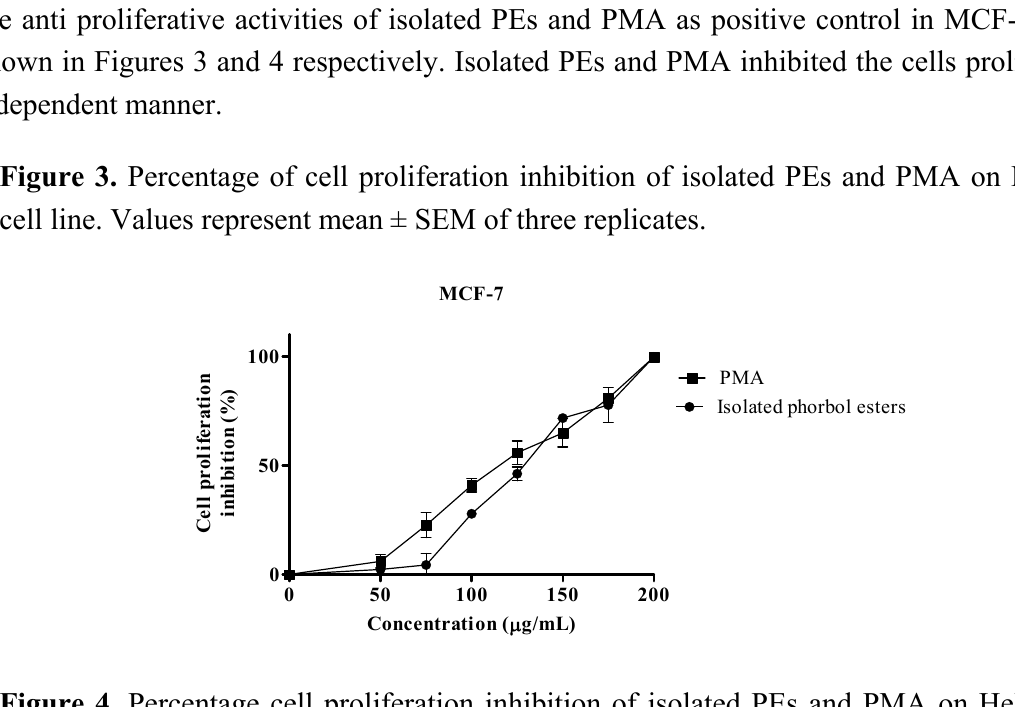
Figure 4. Percentage cell proliferation inhibition of isolated PEs and PMA on HeLa cell line. Values represent mean ± SEM of three